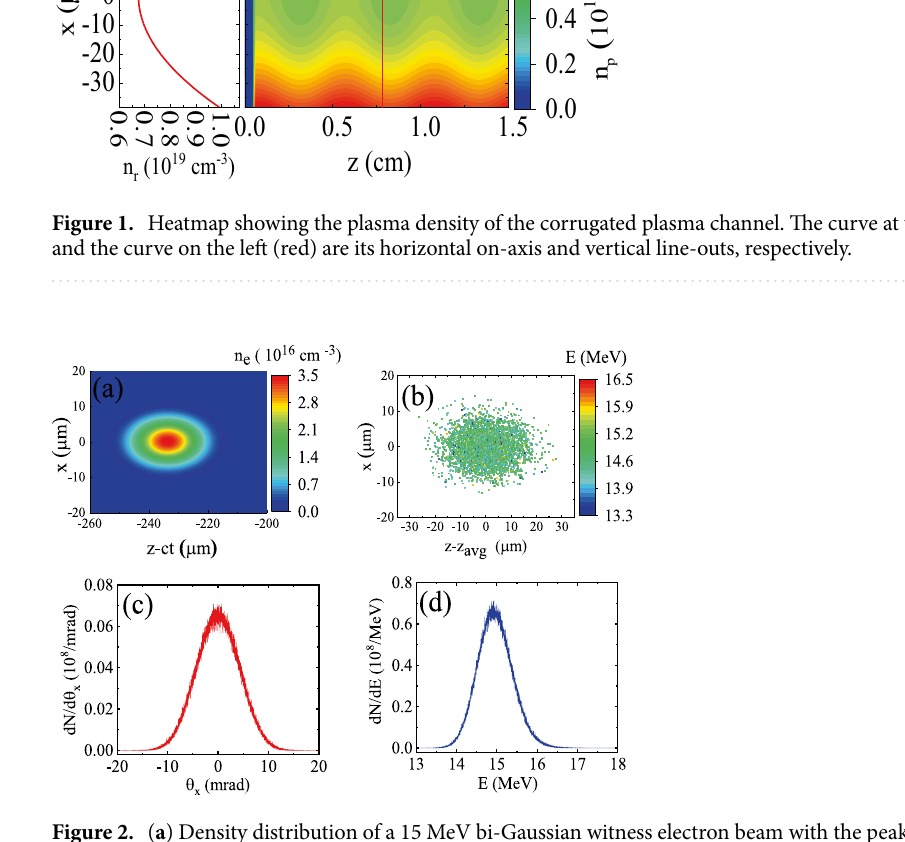
P x represent the longitudinal and transverse particle momenta, respectively. The mean divergence angle of the bunch is only 3.4 mrad. For the bunch described above, the transverse normalized rms emittance is initially calculated to be ε N, x = 0.5 π -mm-mrad according to the following definition: